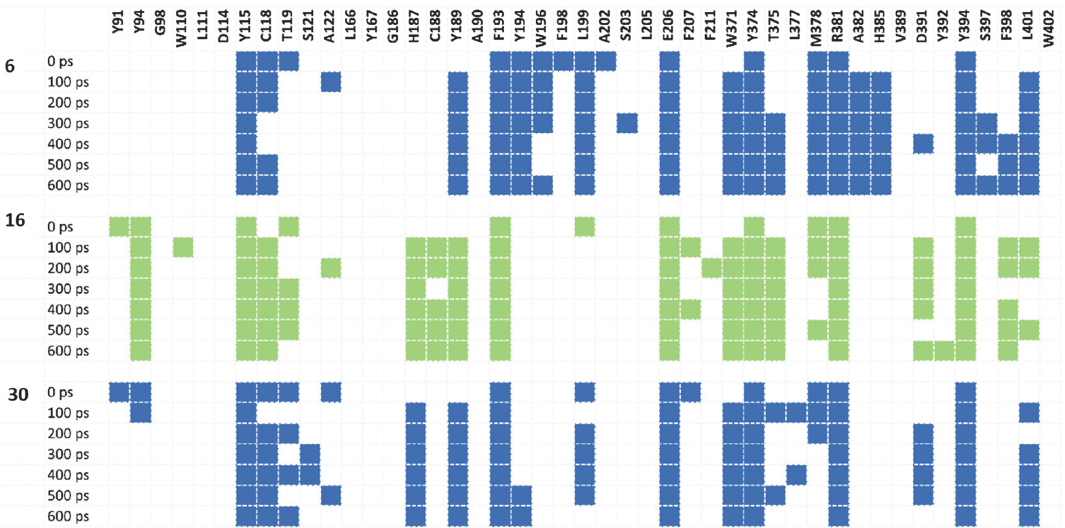
Figure 7. Interaction fingerprints of compounds 6 , 16 and 30 (blue, green and blue, respectively) and with H 3 R during MD simulation for particular frames. Colored box indicates any interaction between the ligand and the corresponding amino acid.